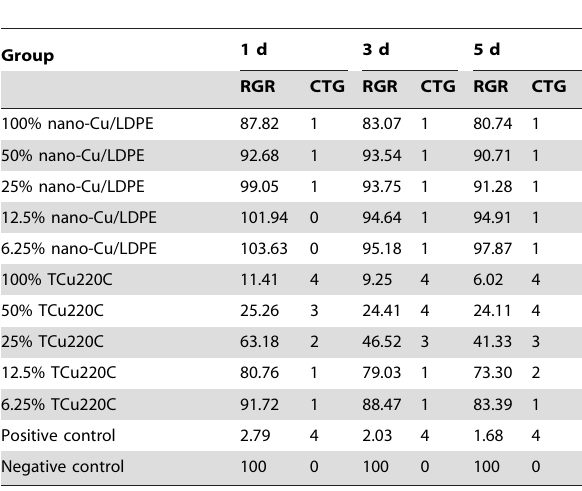
Table 2. Cytotoxicity assay determined as RGR and CTG of the L929 mouse